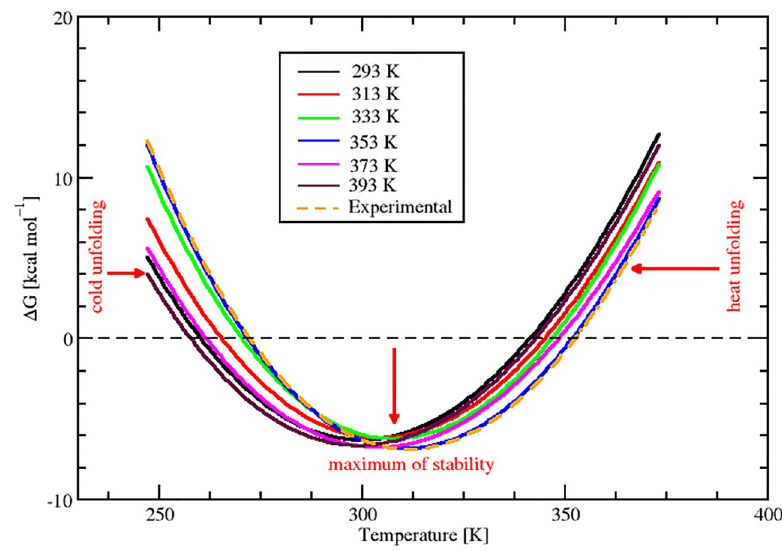
Fig 7. Superimposed stability curves. Comparative stability diagram of predicted Gibbs free energy for different conformational ensembles of SazCA. The experimental Gibbs free energy has also been plotted with dashed line for comparison.